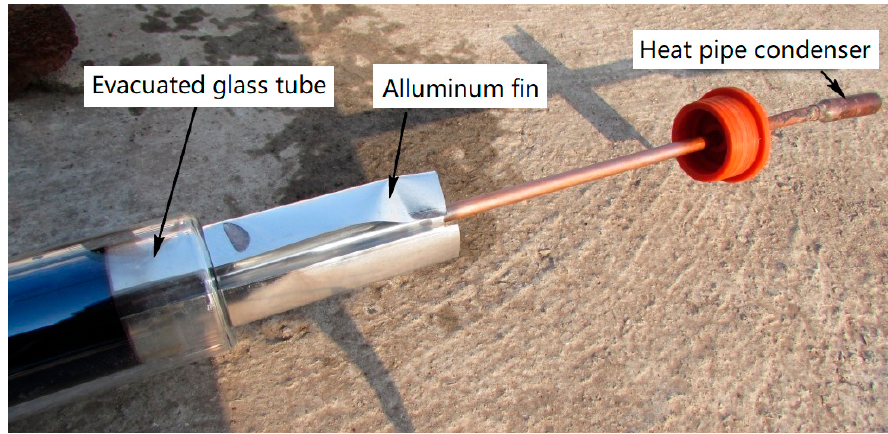
Figure 18. View of a CPC with evacuated tube heat pipe [39].